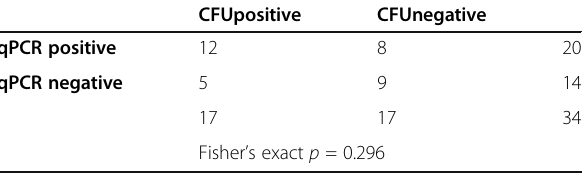
Table 1 Comparison between results of cultural and molecular methods on water samples from 13 Healthcare